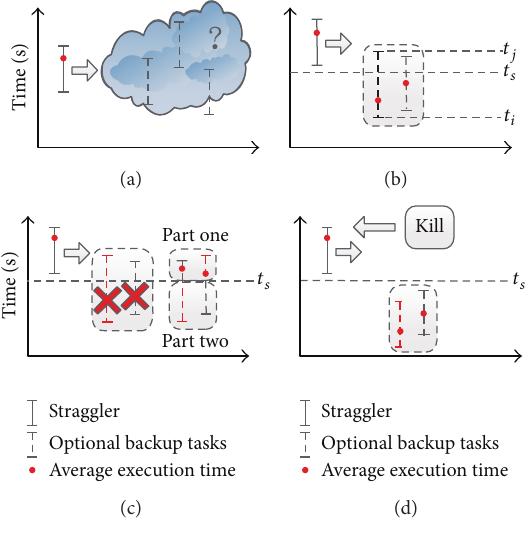
Figure 9: An example for different time profit per unit. The time profit is divided into two parts. So we considered separately these two parts.